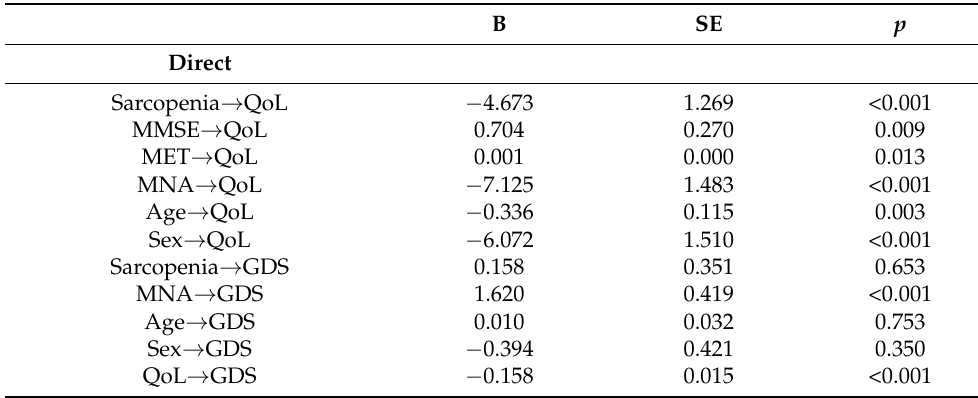
Figure 1. Path model of sociodemographic characteristics and quality of life of the participants on depressive symptoms (MMSE, Mini-Mental State Examination; MNA, Mini Nutritional Assessment). Table 4. Direct, indirect, and total effects of multiple determinants on depressive symptoms in the